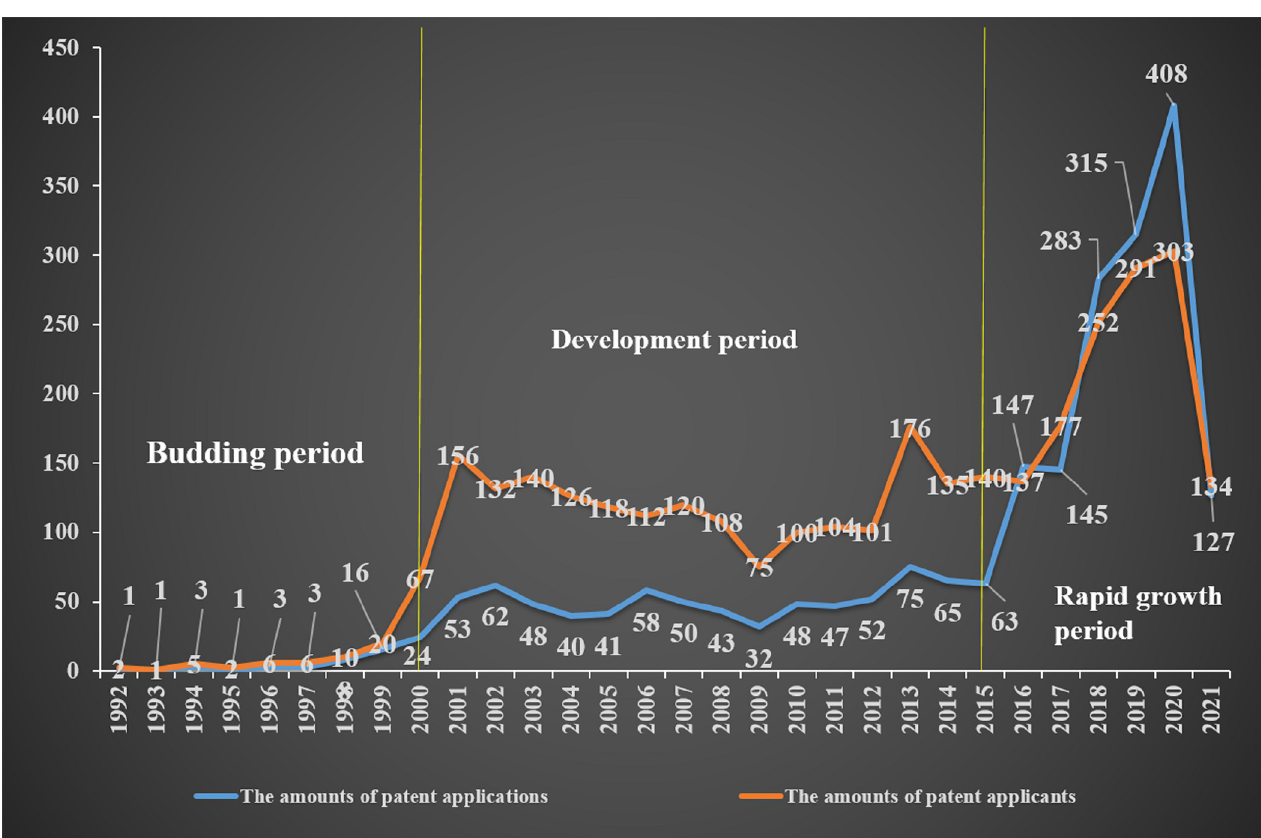
Fig 2. The technology life-cycle of the field of AI-assisted pathology, with the amounts of patent applications and patent applicants. The three stages were (1) Budding period: 1992–2000; (2) Development period: 2001–2015; (3) Rapid growth period: 2016–2021.